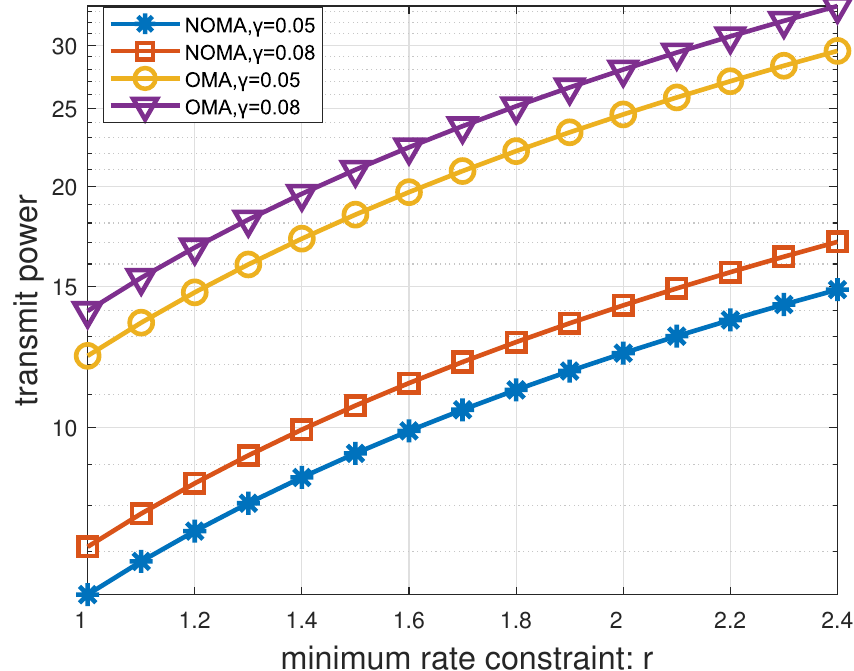
Figure 4. Transmit power versus minimum rate constraint r , when L = 2, ρ = 0.05 .